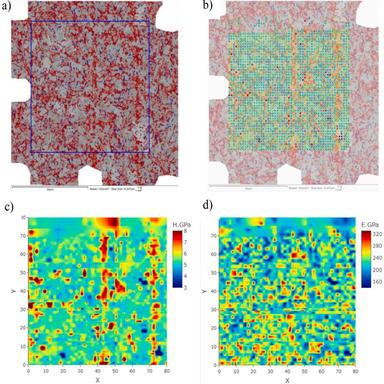
(a) EBSD map with ROI depicted within the boundaries of the blue square, (b) overlap of the nanoindentation hardness 2D scatter plot and EBSD map in the same ROI, (c) indentation hardness map, (d) indentation modulus map. X and Y coordinates are presented in µm.